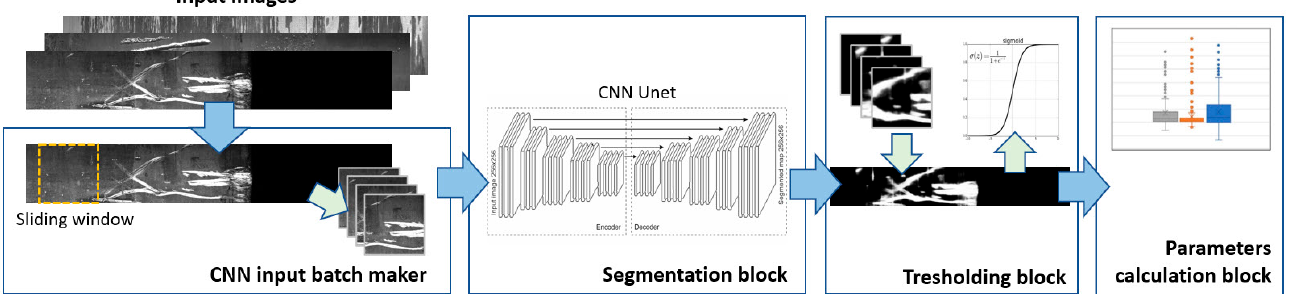
Figure 2. Flowchart of the proposed method of surface defect investigation.